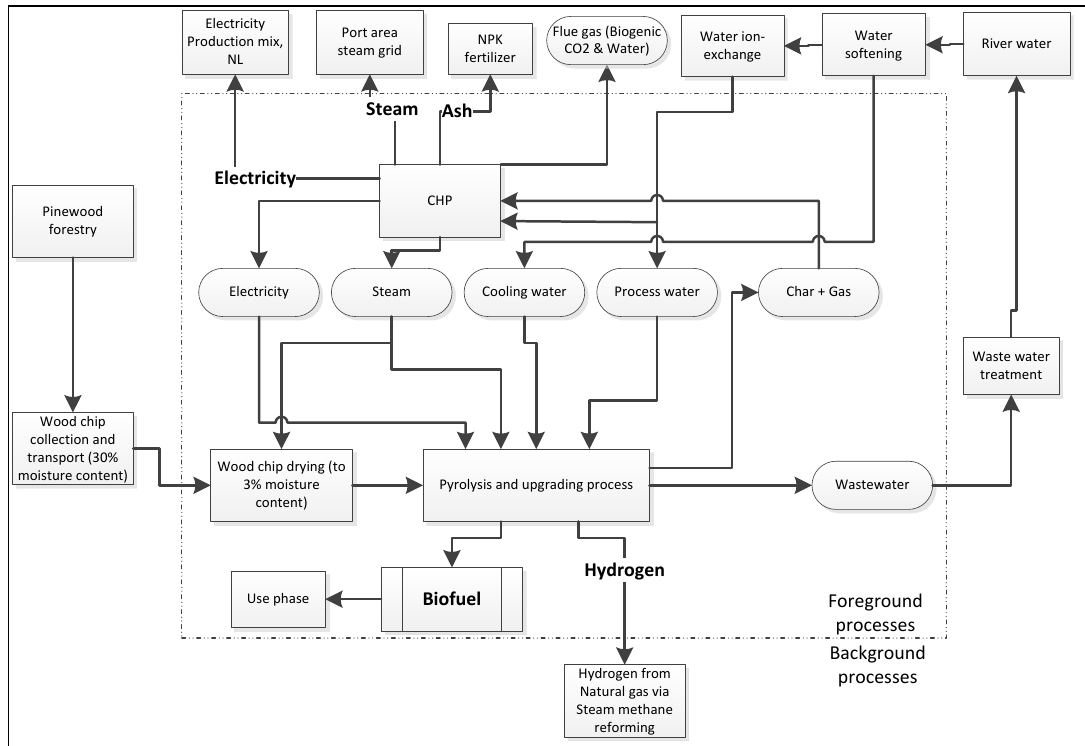
Figure 2. System diagram for biofuel production from pinewood chips via pyrolysis.